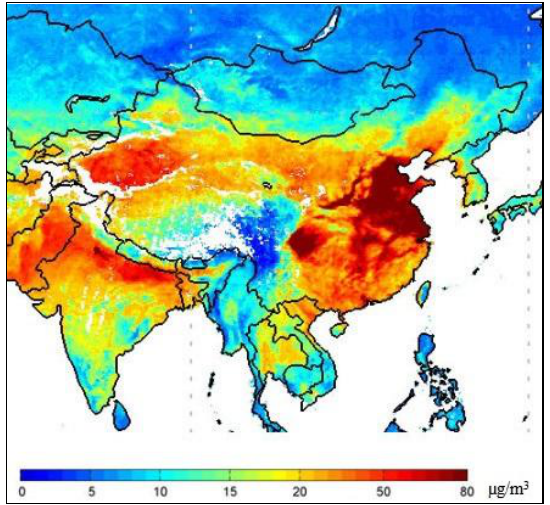
Figure 1. Model map of areas under air pollution based on monitoring data of PM